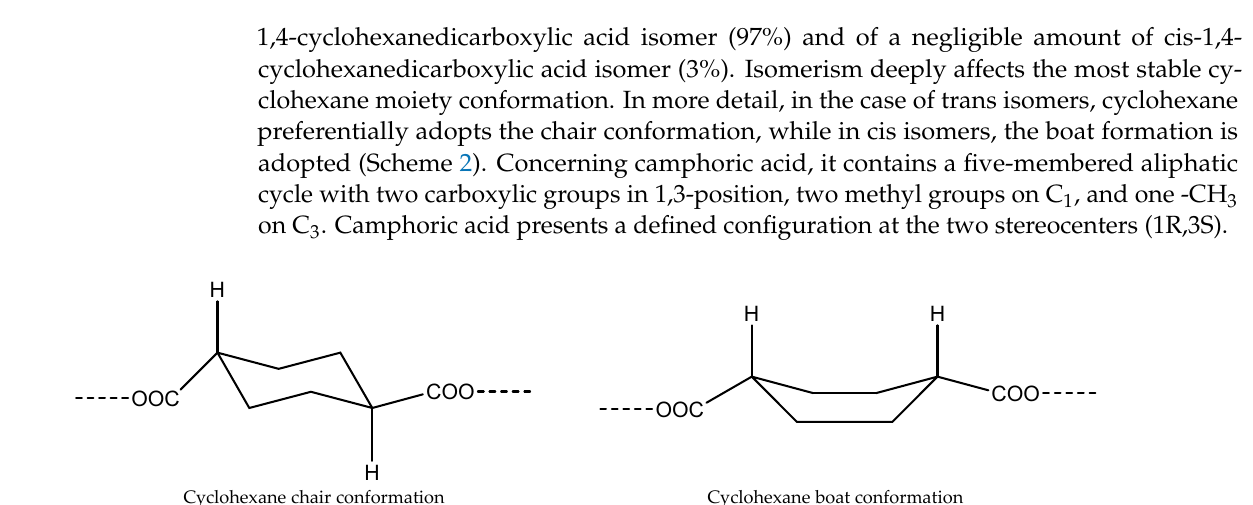
Figure 1. 1 H-NMR spectrum of P(BCE 85 BCE 15 ) copolymer with the corresponding peak